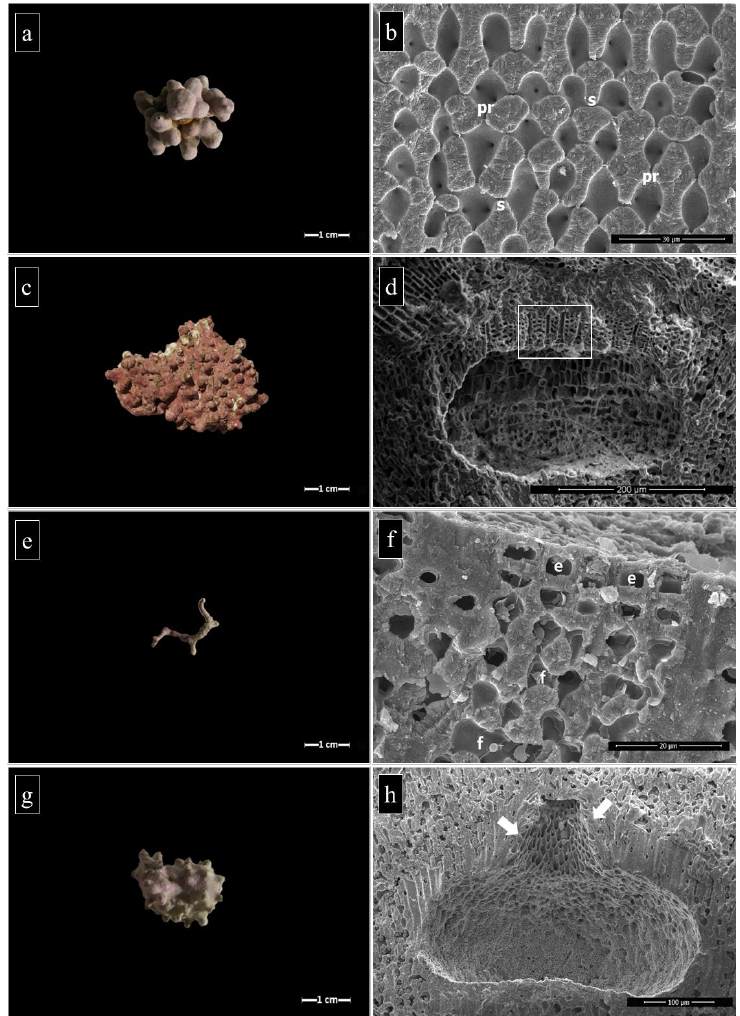
Figure 7. Examples of rhodolith specimens’ morphology and SEM images of their inner structure. a. Fruticose rhodolith of Lithophyllum racemus from Ischia (specimen IS-12). b. Perithallus of L. racemus (AB-12). Note the primary (pr) and secondary (s) pit connections. c. Warty rhodolith of Lithothamnion minervae from Capri (specimen CA-33). d. Multiporate conceptacle of L. minervae (CA-33). Note the pore canals (rectangle). e. Unattached branch of Phymatolithon calcareum from Acciaroli B (specimen AB-03). f. Epithallus and perithallus of P. calcareum (AB-03), with dome-shaped epithallial cells (e) and cell fusions (f). g. Warty rhodolith of Spongites fruticulosus from Acciaroli B (specimen AB-07). h. Uniporate sporangial conceptacle of S. fruticulosus (AB-07). Note the cells protruding laterally into the pore canal (arrows).